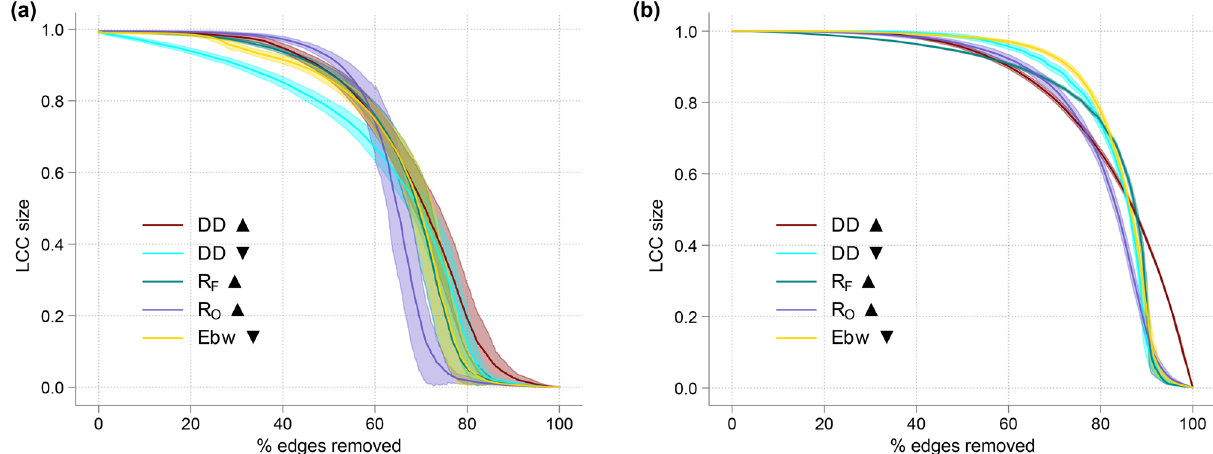
Figure 8. Topological robustness of synthetic networks with respect to deletion of edges based on DD, Forman–Ricci curvature ( R F ), Ollivier–Ricci curvature ( R O ), and edge betweenness centrality (Ebw). ( a ) Erdös– Rényi (ER) network with n = 1000 and p = 0.01 . ( b ) Barabási–Albert (BA) network with n = 1000 and β = 5 . In each case, we show the size of the largest connected component (LCC) normalized by the number of vertices in the graph as a function of the percentage of edges removed. Edges are deleted based on increasing and with the specified